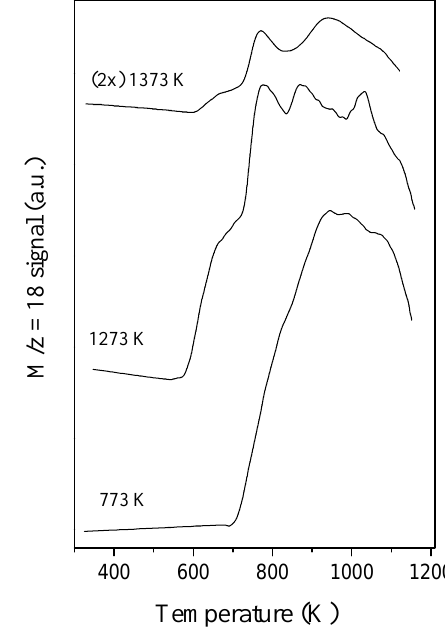
O (42  1 zone axis), b) Ce 2 3